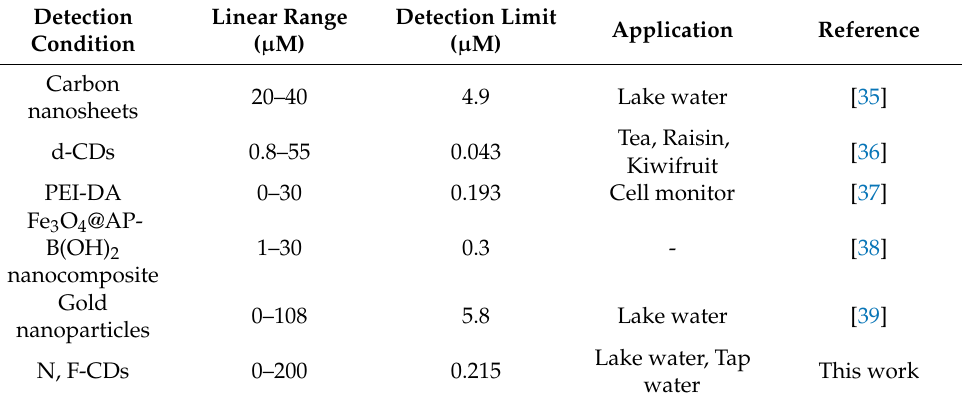
Table 1. Comparison of different optical methods applied for the determination of Cu 2+ .